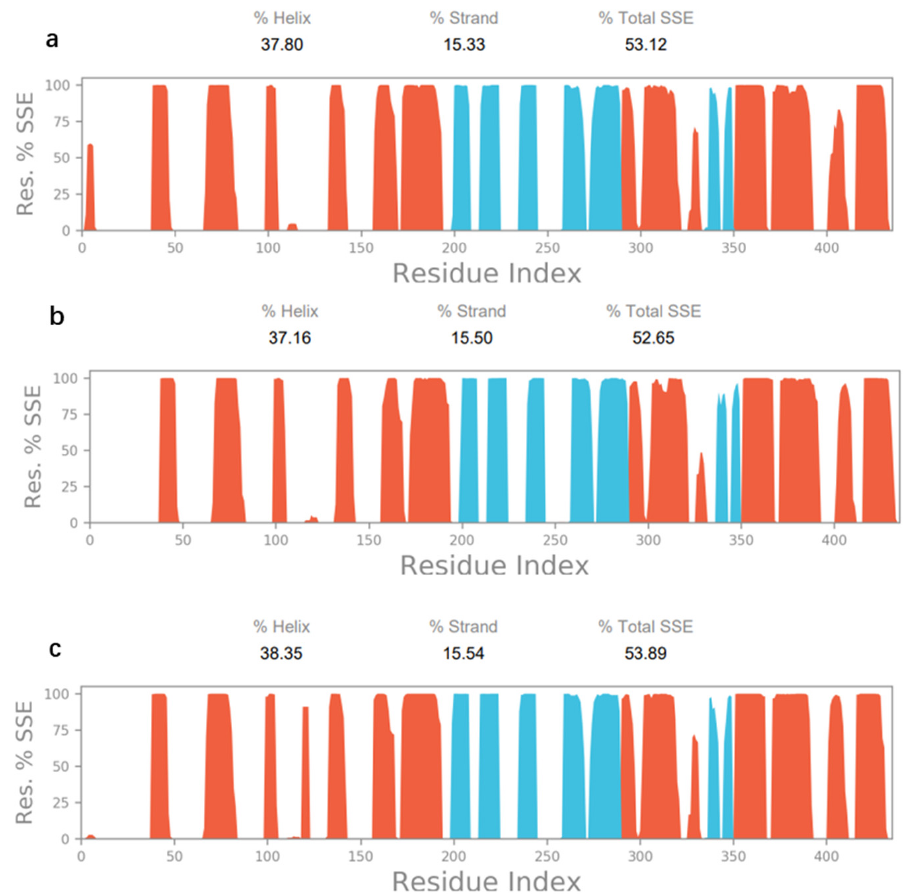
Figure 11. Protein secondary structure elements (SSE) were monitored throughout the simulation. The alpha-helices were labled by orange and the beta-strands were labled by blue. ( a ) Protein secondary structure elements of G07 − 3CM8 during the simulation; ( b ) Protein secondary structure elements of G19 − 3CM8 during the simulation; ( c ) Protein secondary structure elements of G23 − 3CM8 during the simulation.